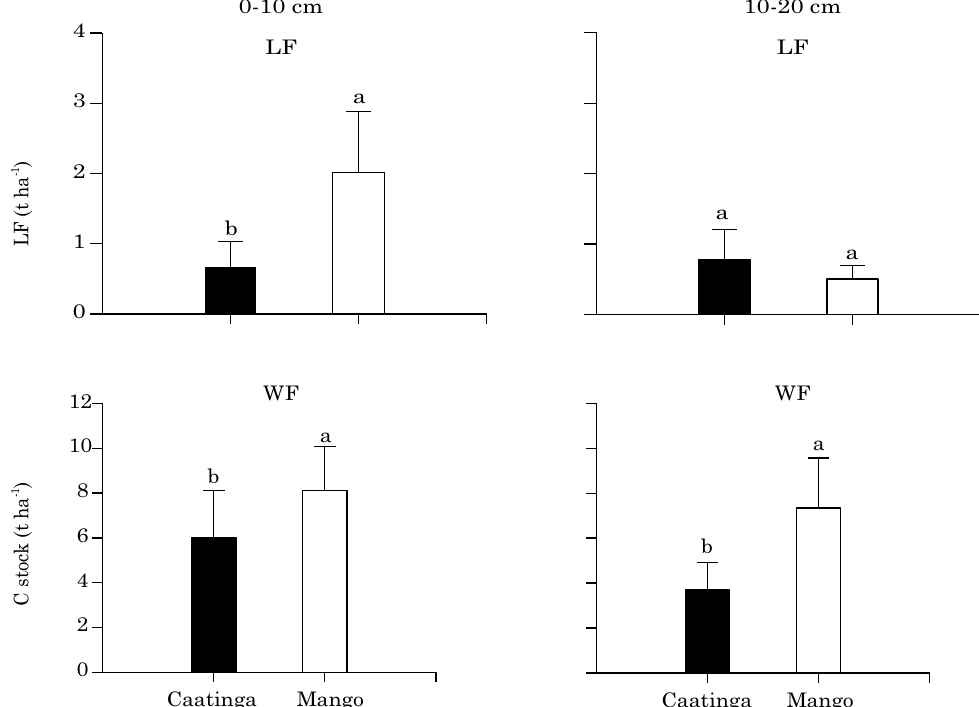
Figure 4. Light fraction (LF) and C stock of the heavy fraction (WF) of soil organic matter in the 0-10 and 10-20 cm layers of the soil under irrigated mango and native caatinga . Columns designated with the same letter do not differ by the Student t test (α = 5 %). The vertical deviation bars represent the standard deviation of the